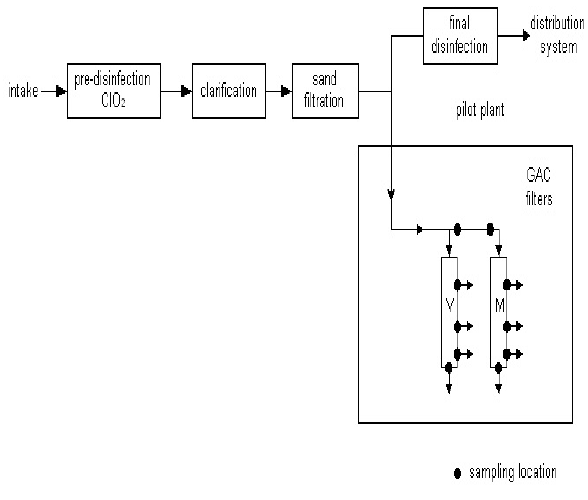
Fig. 1a. Scheme of Fortore Drinking Water Treatments Plant